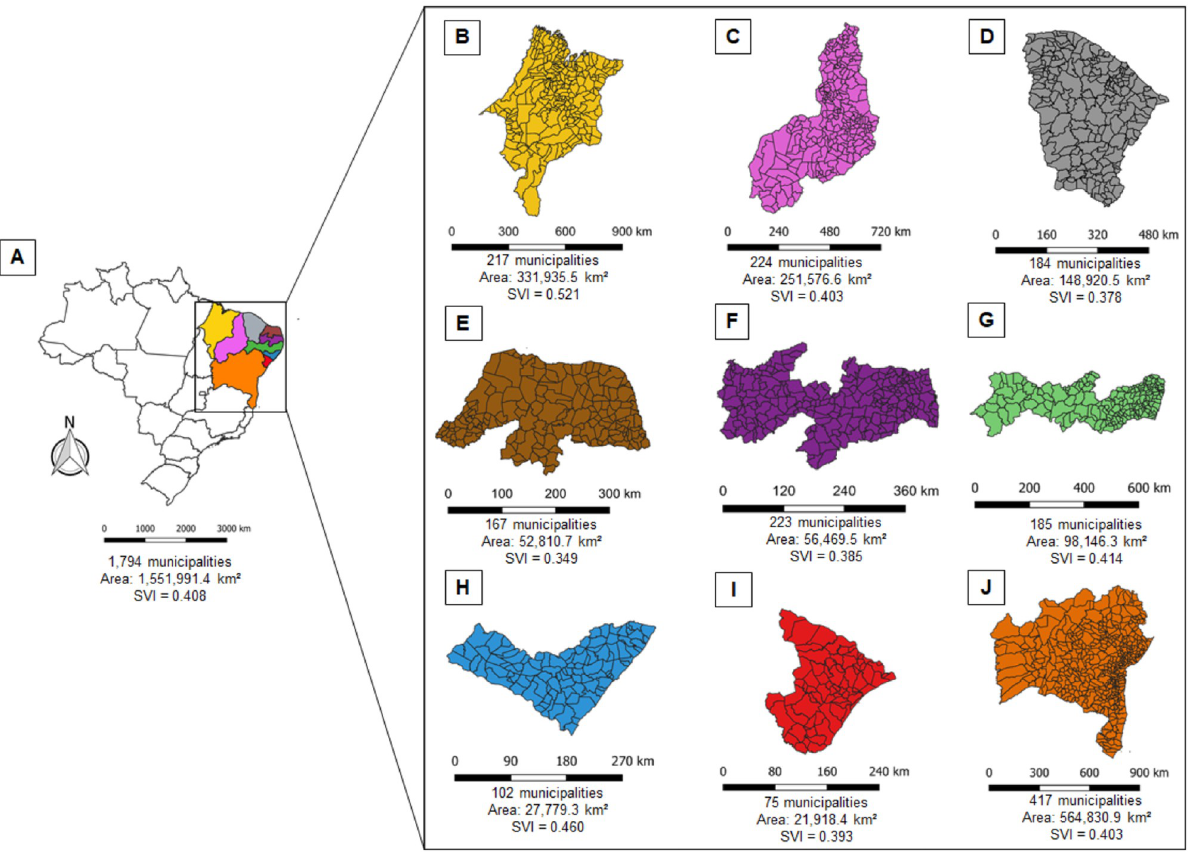
Fig 1. Study area. (A) Northeast–NE, Brazil. (B) Maranh ã o–MA. (C) Piauı´–PI. (D) Ceara´–CE. (E) Rio Grande do Norte–RN. (F) Paraı´ba–PB. (G) Pernambuco–PE. (H) Alagoas–AL. (I) Sergipe–SE. (J) Bahia–BA. SVI: Social vulnerability